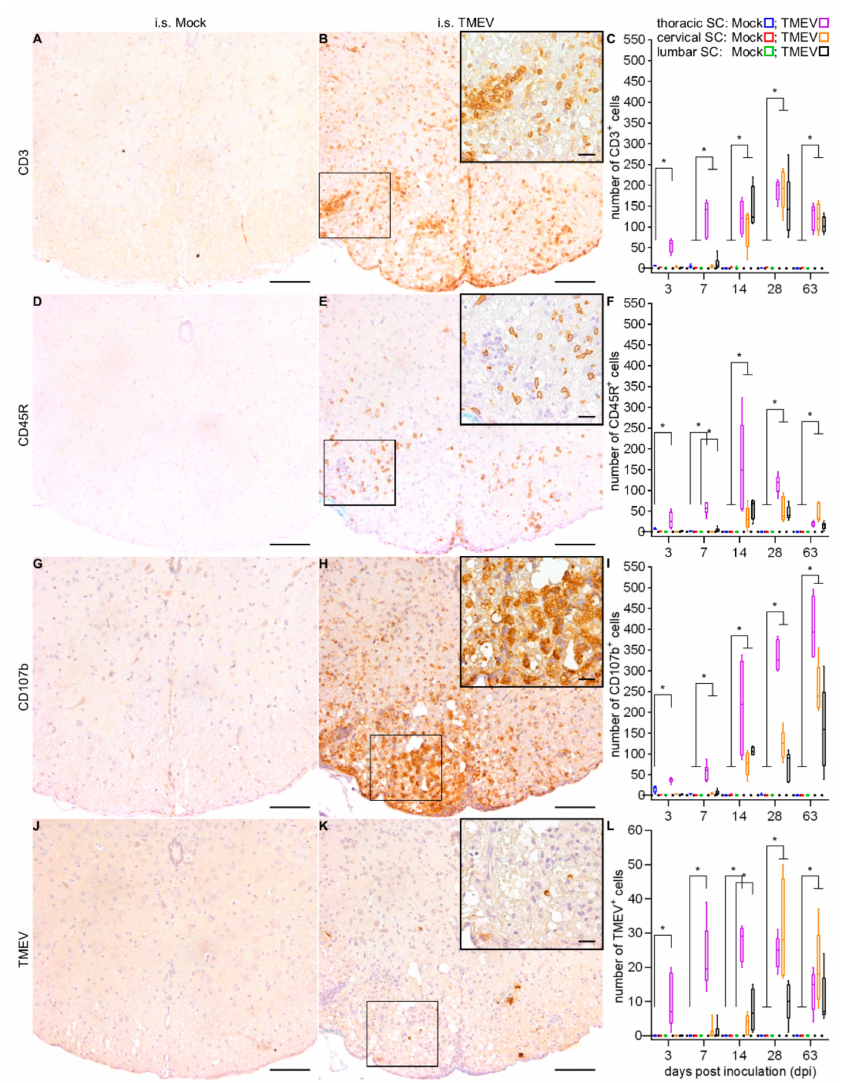
Figure 3. Immunophenotyping of inflammatory cells and quantification of TMEV positive cells within the SC following i.s. mock-injection (at 14 dpi; A , D , G , J ) and TMEV infection (at 14 dpi; B , E , H , K ). Statistical analysis revealed significantly increased numbers of CD3 + (T lymphocytes), CD45R + (B lymphocytes) and CD107b + (microglia / macrophages) cells ( C , F , I ), as well as a spread of virus protein ( L ) following i.s. TMEV infection. Box-and-whisker plots show median and quartiles. Significant di ff erences between the groups as detected by a Mann–Whitney U-test are indicated by asterisks (* p < 0.05). Bars represent 100 µ m in the overviews and 20 µ m in the inserts. Associated with the spatial and temporal distribution of inflammation and TMEV protein, demyelination, as detected by a reduction of myelin basic protein (MBP) labeled white matter area, was observed within the thoracic SC at 14, 28 and 63 dpi, within lumbar SC at 28 and 63 dpi, and within cervical SC at 63 dpi (Figure 4A–C). Axonal damage as detected by β -APP around the injection site of TMEV-infected animals at 14, 28 and 63 dpi, a ff ecting lumbar and cervical SC at a late time point (63 dpi; + + Figure 4D–F). The occurrence of periaxin Schwann cells and TdTomato NG2 lineage cells were observed in the thoracic SC of TMEV-infected animals at late time points (28 and 63 dpi). At 28 dpi, the number of Schwann cells (Figure 4G–I) and NG2 lineage cells (Figure 4J–L) was significantly + increased in the thoracic SC while mock-injected animals did not show any periaxin